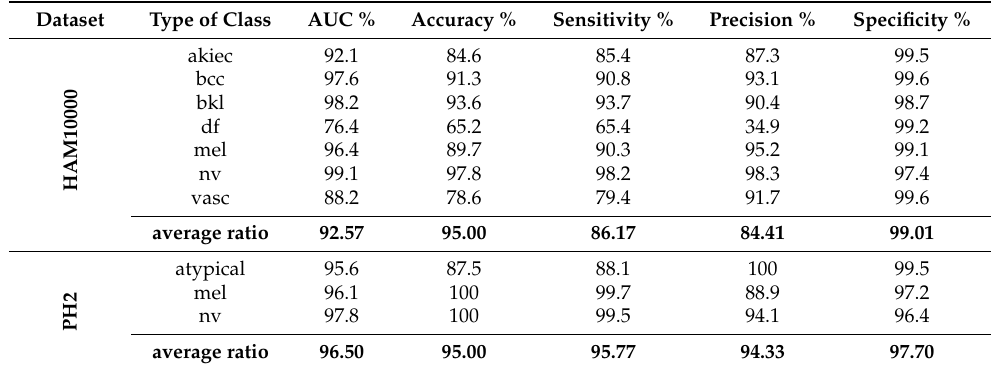
Table 5. Performance of SVM with MobileNet features for dermoscopic image analysis to classify HAM10000 and PH2 dataset skin lesions.